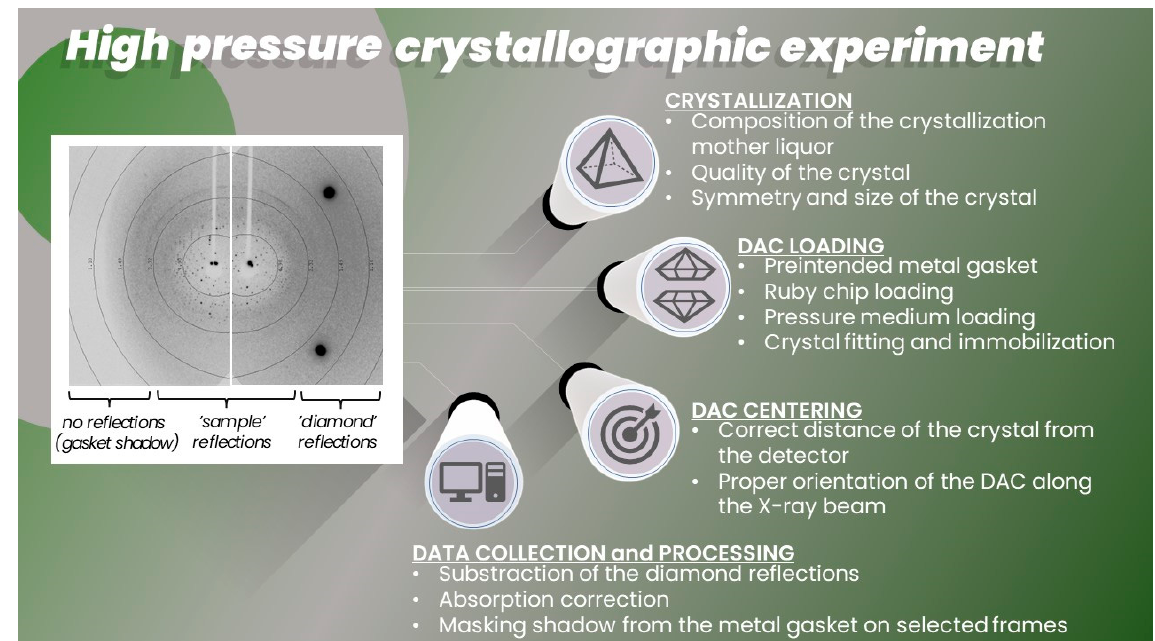
Figure 4. Schematic representation of a HPMX experiment.